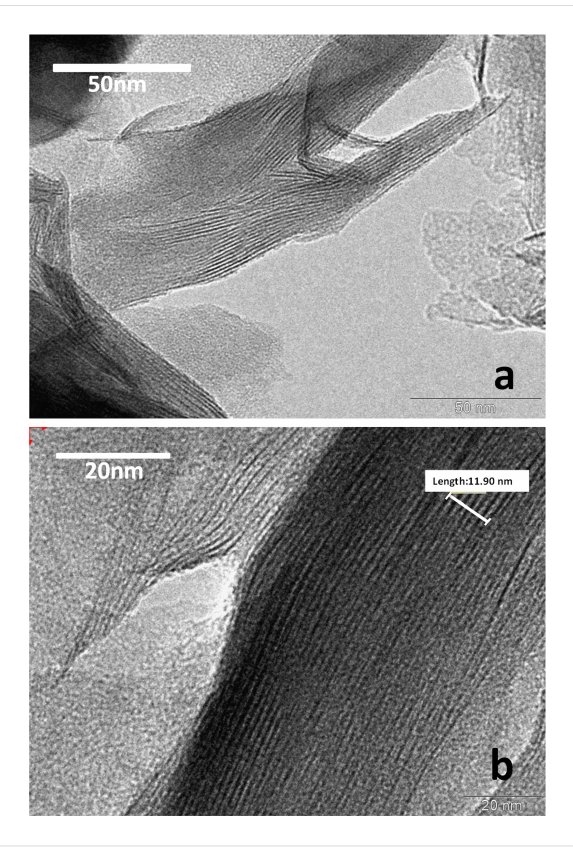
Figure 4: TEM images of the Z-MMT_S2-46 biohybrid sample. In b) the region used to estimate the basal space distance is signaled (seven